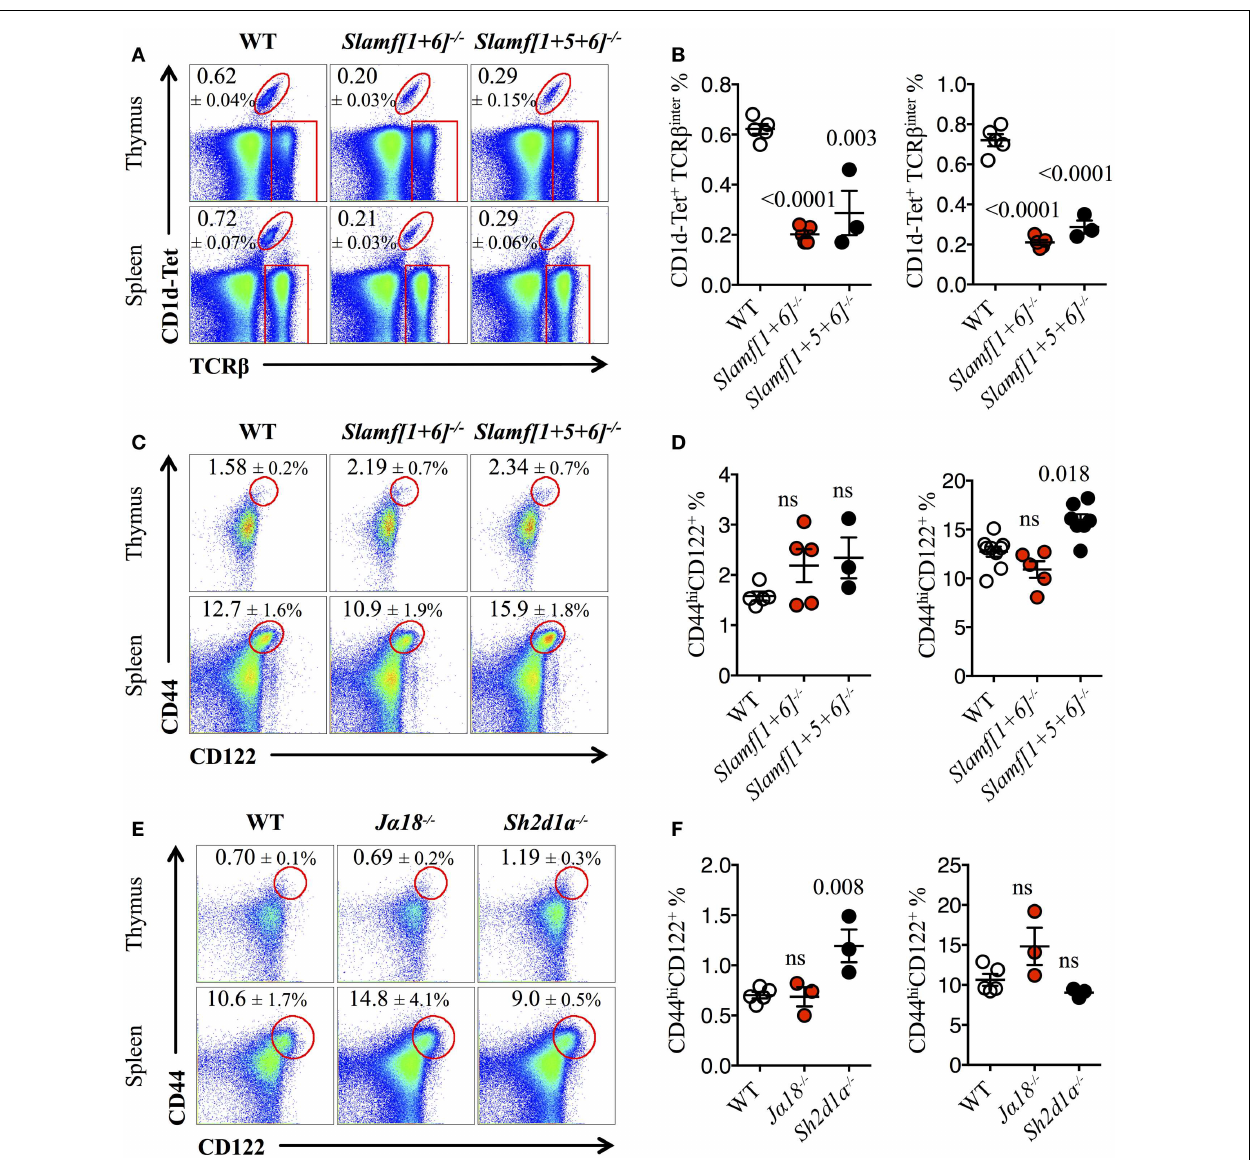
Slamf[1 + 5 + 6] − / − B6 mice. (E) Representative FACS plots showing the expression of CD44 and CD122 on CD8SPT cells from thymus or spleen of WT, J α 18 − / − or Sh2d1a − / − B6 mice. FACS plots are gated on live singlets lymphocytesTCR β hi CD8SP ( thymus ) orTCR β + CD8SP ( spleen ). (F) Percentage of CD44 hi CD122 + CD8SPT cells in thymus ( left ) or spleen ( right ) ofWT, J α 18 − / − or Sh2d1a − / − B6 mice. Numbers inside plots show the mean percentage ± SD of NKT cells (A) , or innate-like CD8 + T cells (C, E) . Red rectangles in (A) depict the lymphocyte gate in which innate CD8 + T cells were analyzed. Cumulative graphs show the results of two independent experiments, mean ± SEM.The p values were calculated by unpaired t -test between theWT group and the knockout group. A value of p < 0.05 was considered significant; ns,